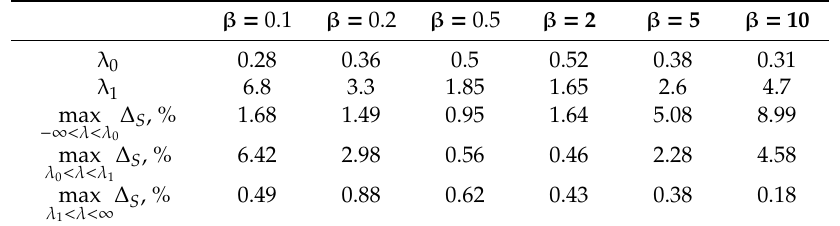
Table 2. Maximum relative error ∆ a of the simplified expression a P in di ff erent ranges of λ . β = 0.1 β = 0.2 β = 0.5 β = 2 λ 1